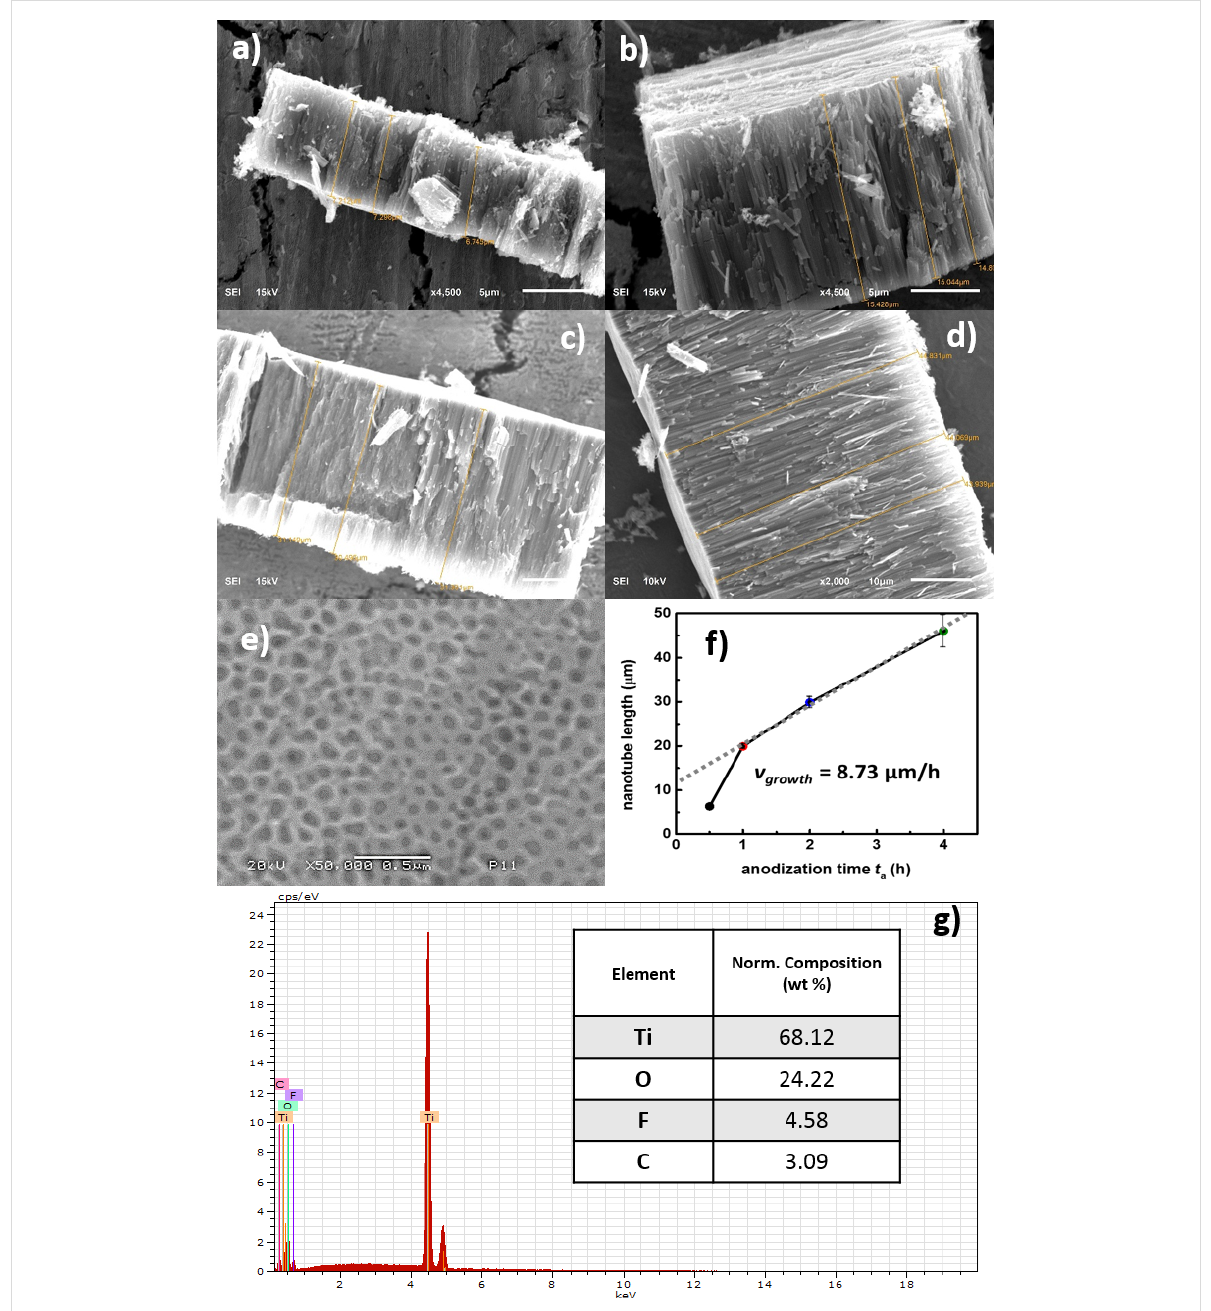
Figure 1: SEM images, a) top and b) cross section, of TNTs for each of the anodization times ( t a ): c) 0.5 h, d) 1 h, e) 2 h, and f) 4 h. g) EDS spectra of a TNT array after 0.5 h of anodization.